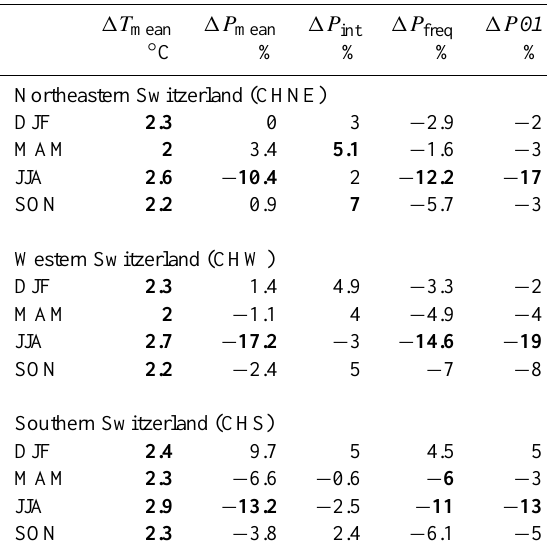
Table 1. Median climate change signals (2045–2074 vs. 1980– 2009) of mean temperature ( 1T mean ) and mean precipitation ( 1P rmean ) as presented in Fischer et al. (2011), as well as of precip- itation intensity ( 1P int ), frequency ( 1P freq ), and dry-to-wet tran- sition probability ( 1P 01 ) for the three Swiss domains (Fig. 1) and four seasons. Figures in bold denote significant signals with respect to the distribution of the multi-model climate change scenarios (5% significance